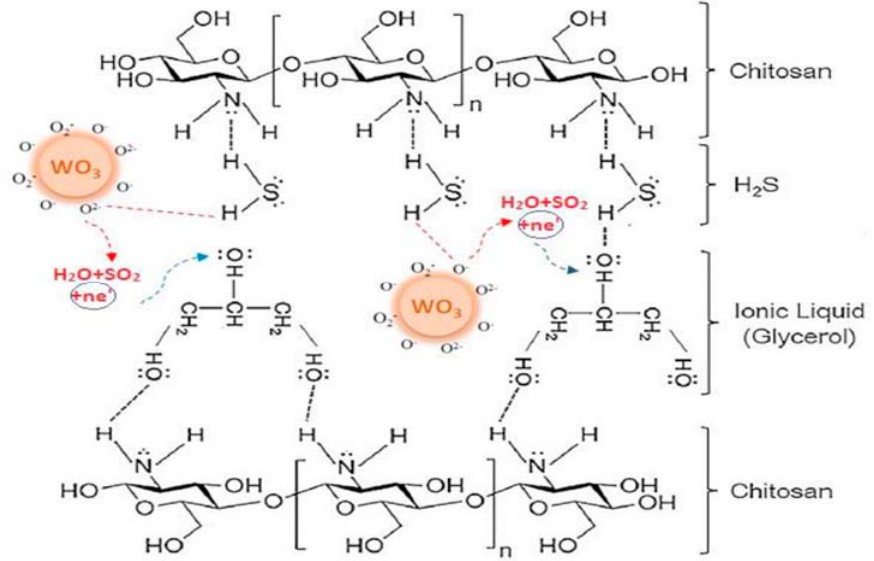
Figure 7. Participation of all sensor components in H 2 S detection at 40 °C. Reproduced with permission [84]. Copyright 2020, Elsevier.